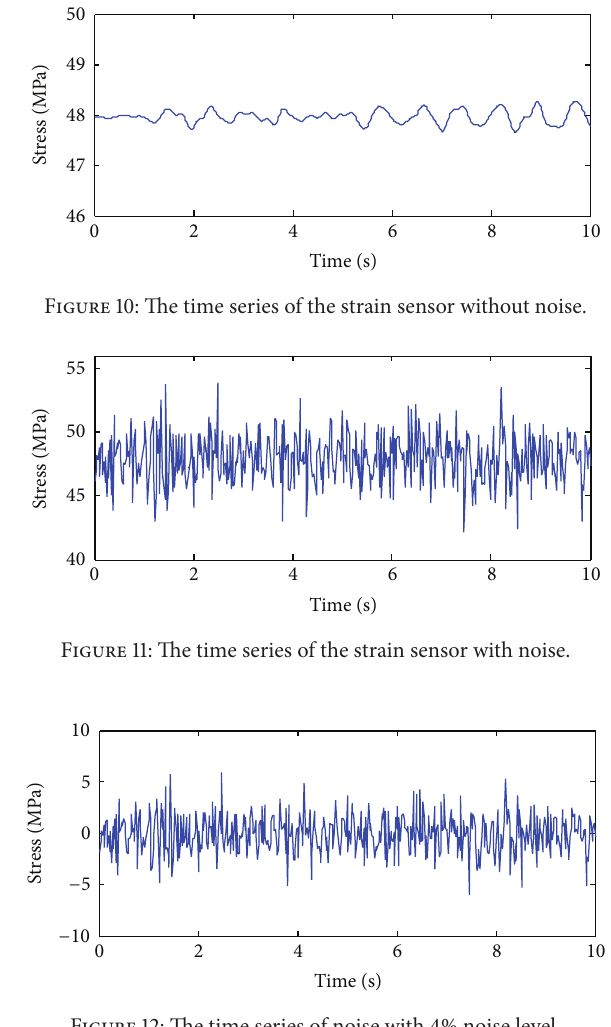
Figure 12: The time series of noise with 4% noise level.